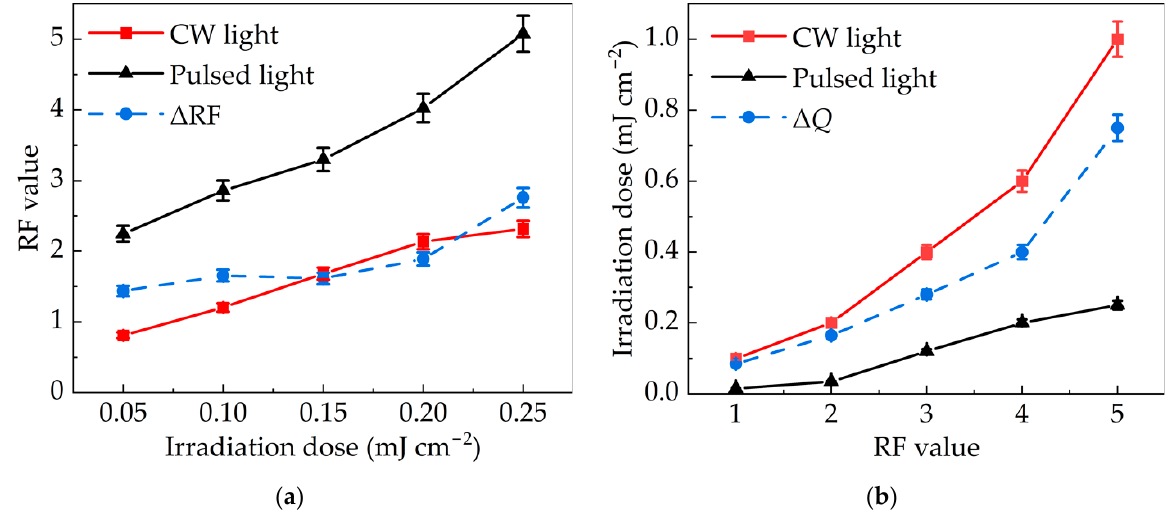
Figure 7. Comparison of inactivation effects between pulsed light and CW light with the same average irradiance per second: ( a ) RF value under the same irradiation dose and ( b ) dose required under the same RF.